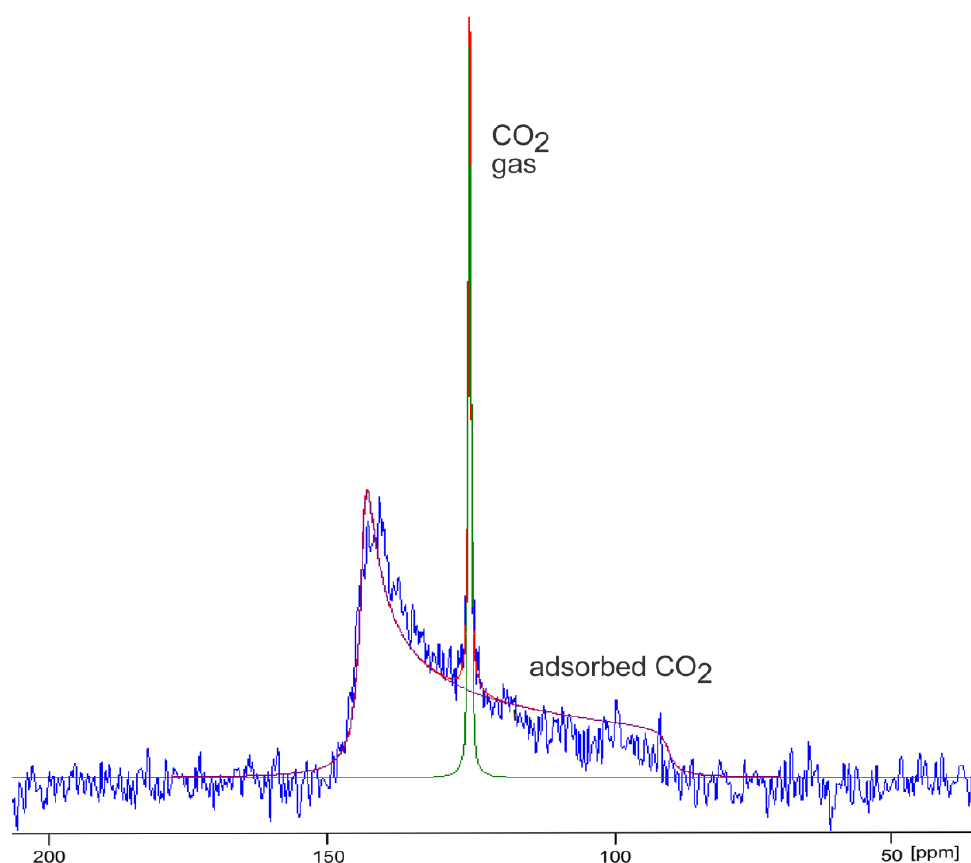
Figure 14. 13 C NMR spectrum of DUT-8(Ni) pressurized with 9.5 bar carbon dioxide measured at 237 K. Note that the initially closed structure opens during the adsorption experiment at temperature-dependent gate-opening pressure ( ca. 5 bar at 237 K) whereas it remains open during desorption down to 1 bar (hysteresis). (Blue: experimental spectrum, green: simulated gas phase signal, magenta: simulated signal of adsorbed CO the simulated signals.) The Figure has been prepared using DMFit